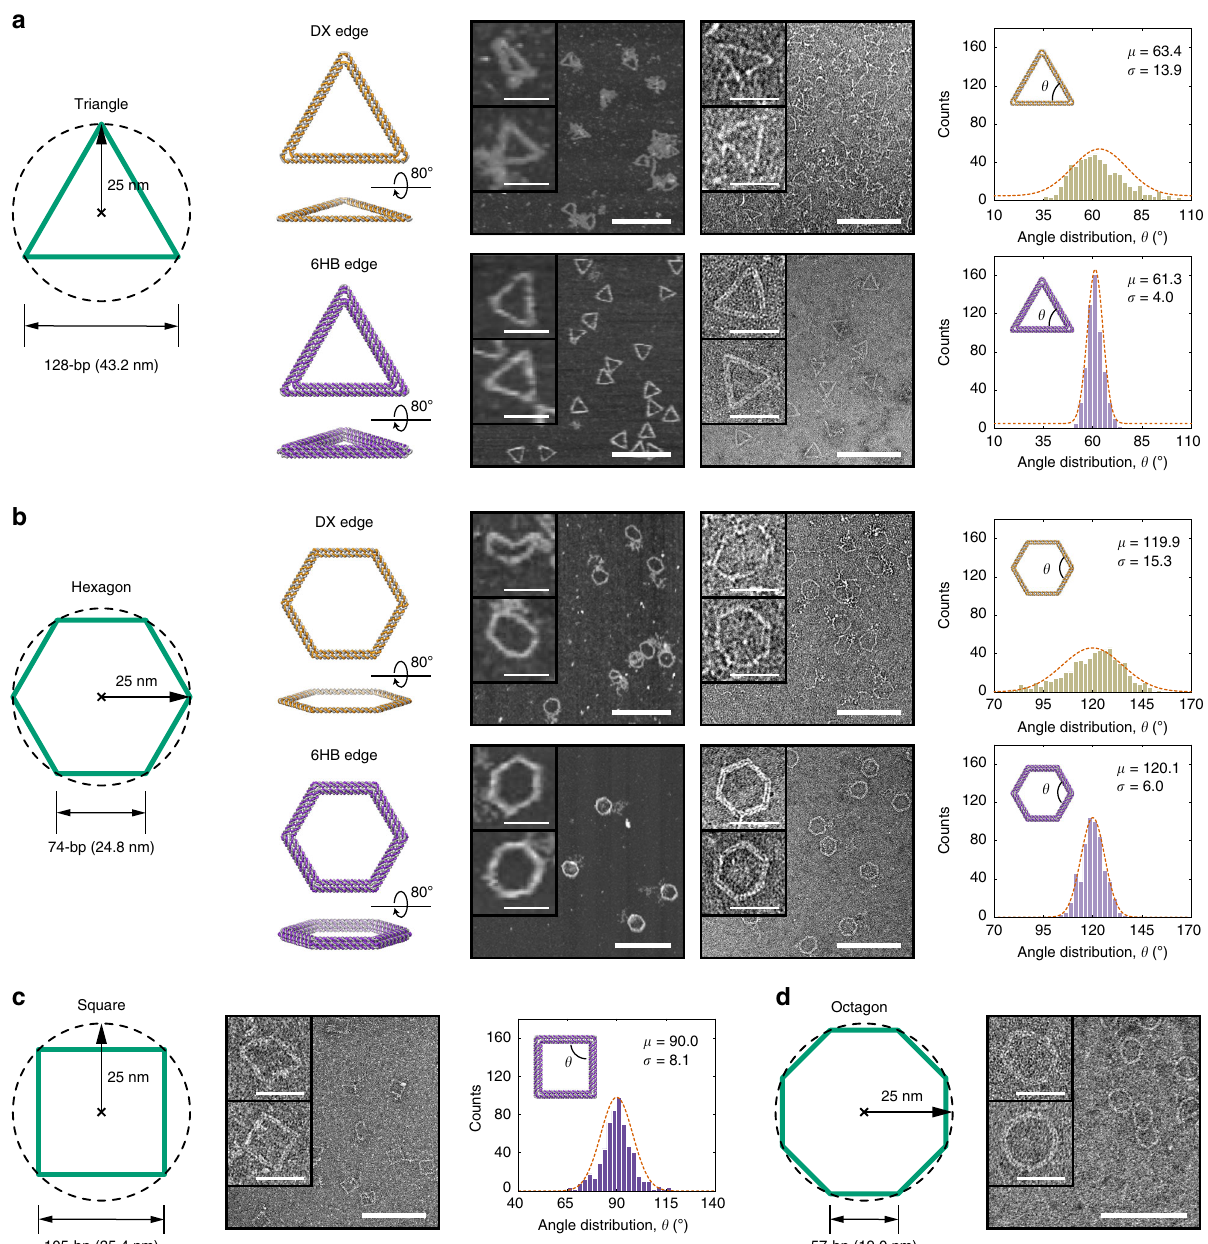
Fig. 3 Controlled arm angles for a triangle, square, hexagon, and octagon without internal mesh. Target geometries without internal mesh are designed with the radius of the circumscribed circle of 25 nm that corresponds to the triangle a with 128-bp edge length and octagon b with 74-bp edge length, corresponding to approximately 43 and 25 nm, respectively. Comparison of DX- and 6HB-based DNA origami objects with (left) AFM, (middle) TEM, and (right) histogram analyses of the distributions in angles. c TEM and histogram analysis of the distributions in angle of the 6HB-based DNA square of 105- bp edge length. d TEM for the 6HB-based DNA octagon of 57-bp edge length. The top zoomed-in image on each panel is the representative object that is the most deformed and the image below represents the object that is the least deformed in shape. Scale bars in zoom-in and zoom-out AFM and TEM images are 50 and 200 nm, respectively. Source Data are available in the Source Data fi